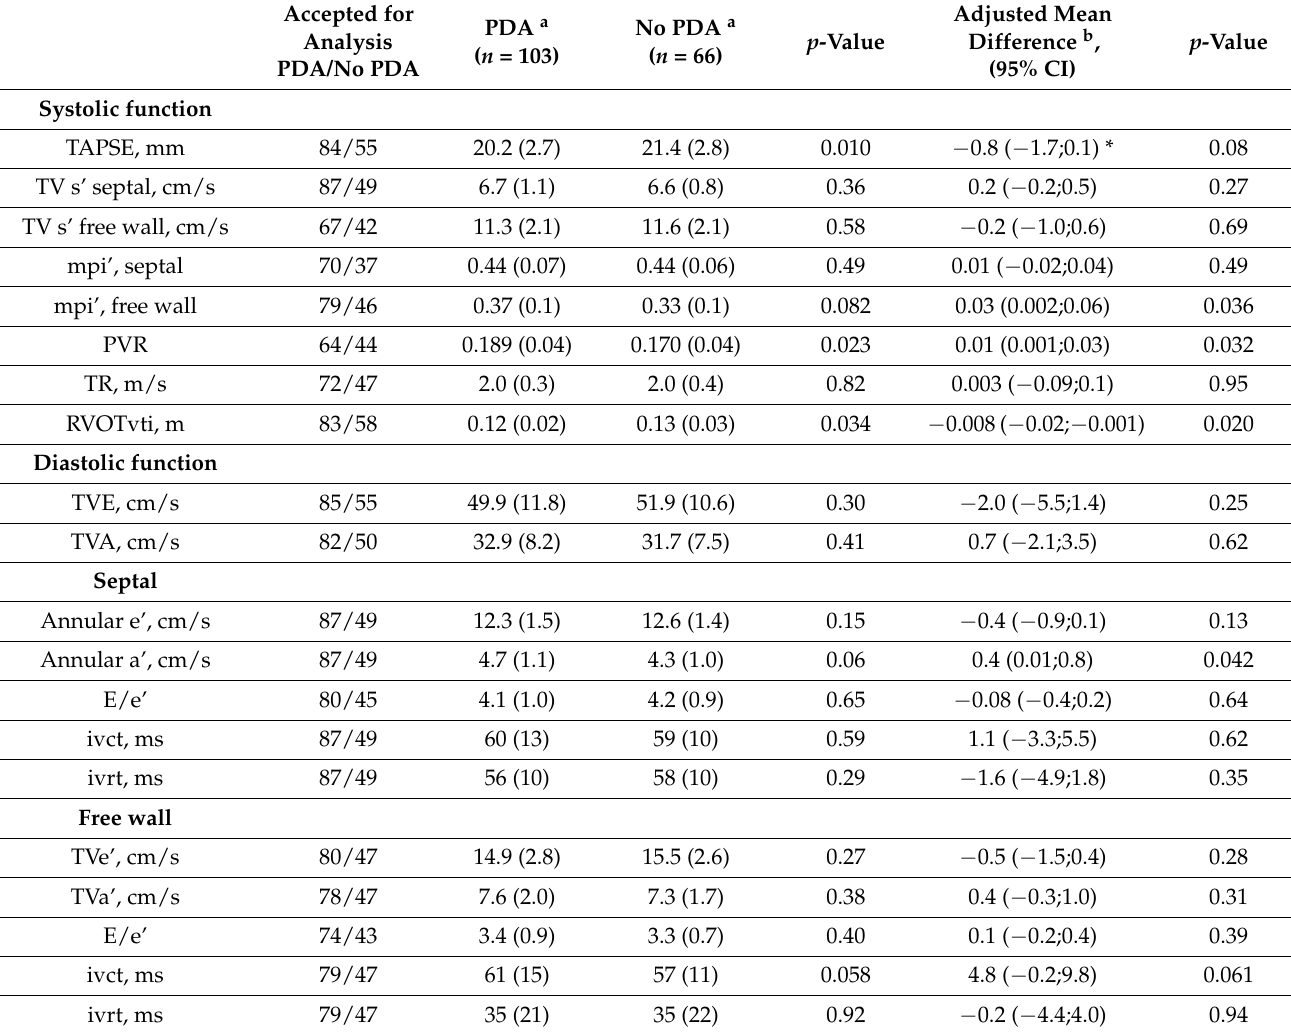
Table 5. Right heart systolic and diastolic function in 6.5-year-old children born extremely preterm (EXPT) stratified by a neonatal treated patent ductus arteriosus